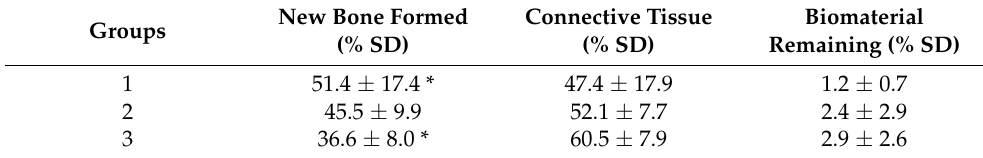
Table 1. Histometric outcomes of the three groups after 6 months of bone